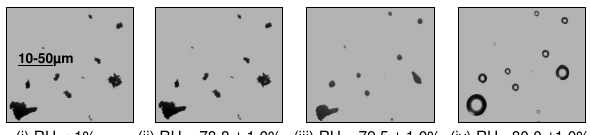
Fig. 6. A series of microscope images of I 2 O 5 crystals at 298K: (i) at low RH, (ii) just below the deliquescence point and (iii) at the point of deliquescence, and (iv) shows aqueous solution